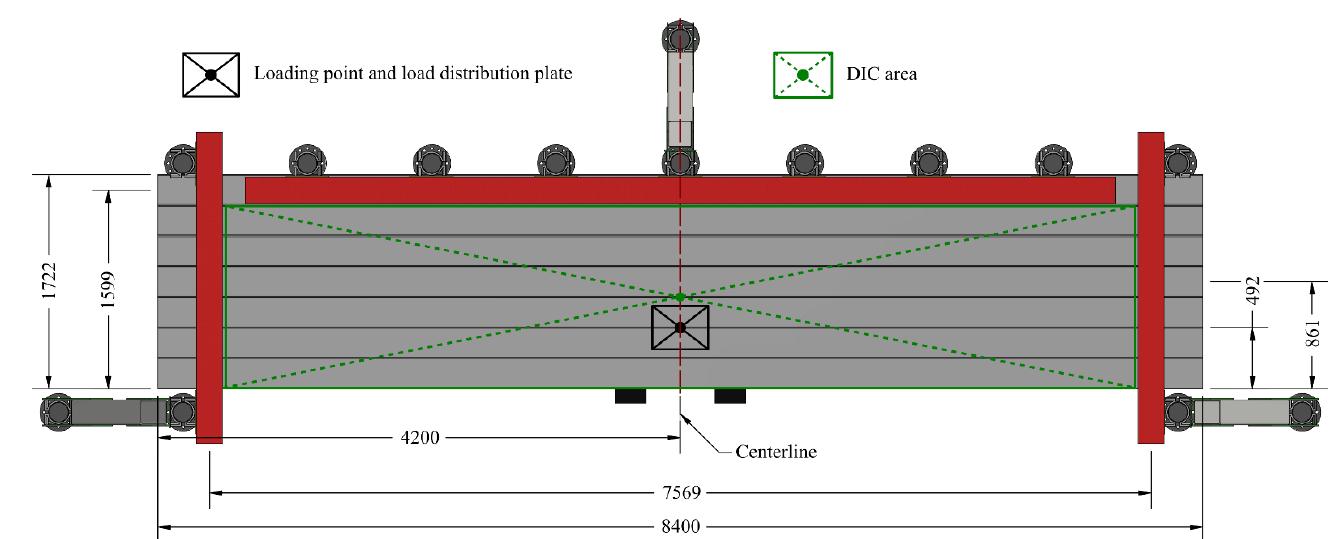
Figure 6. The laboratory test setup viewed from above with loading point and DIC coverage indicated.